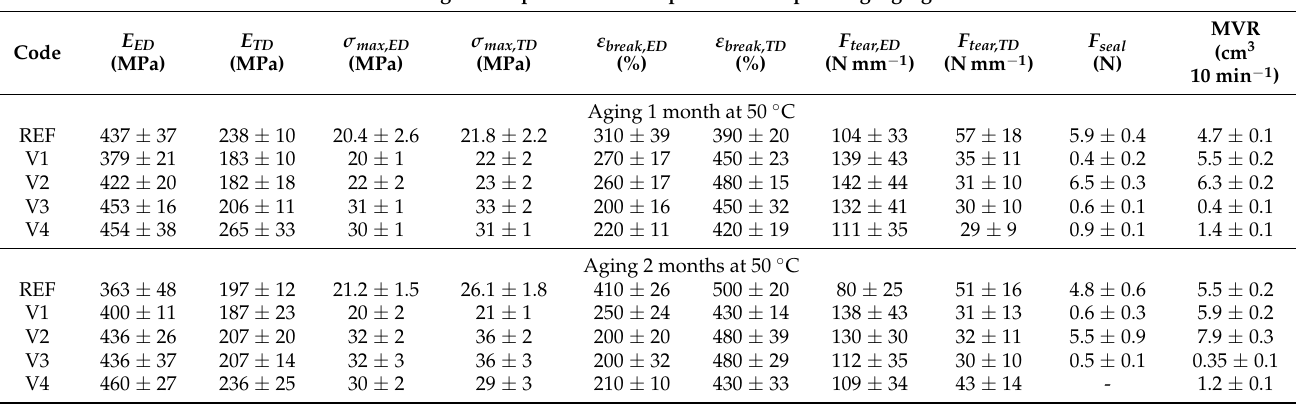
Table 2. MVR and mechanical properties of REF and modified compounds V1 to V4 in the extrusion direction (ED) and transverse direction (TD) aged for 1 and 2 months at 50 ◦